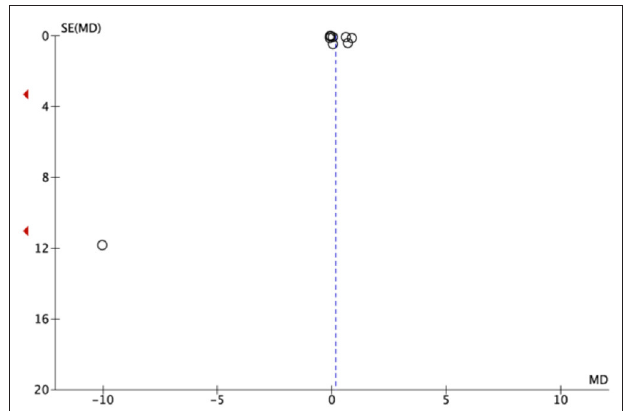
FIGURE 4 | Funnel plot of all included studies.